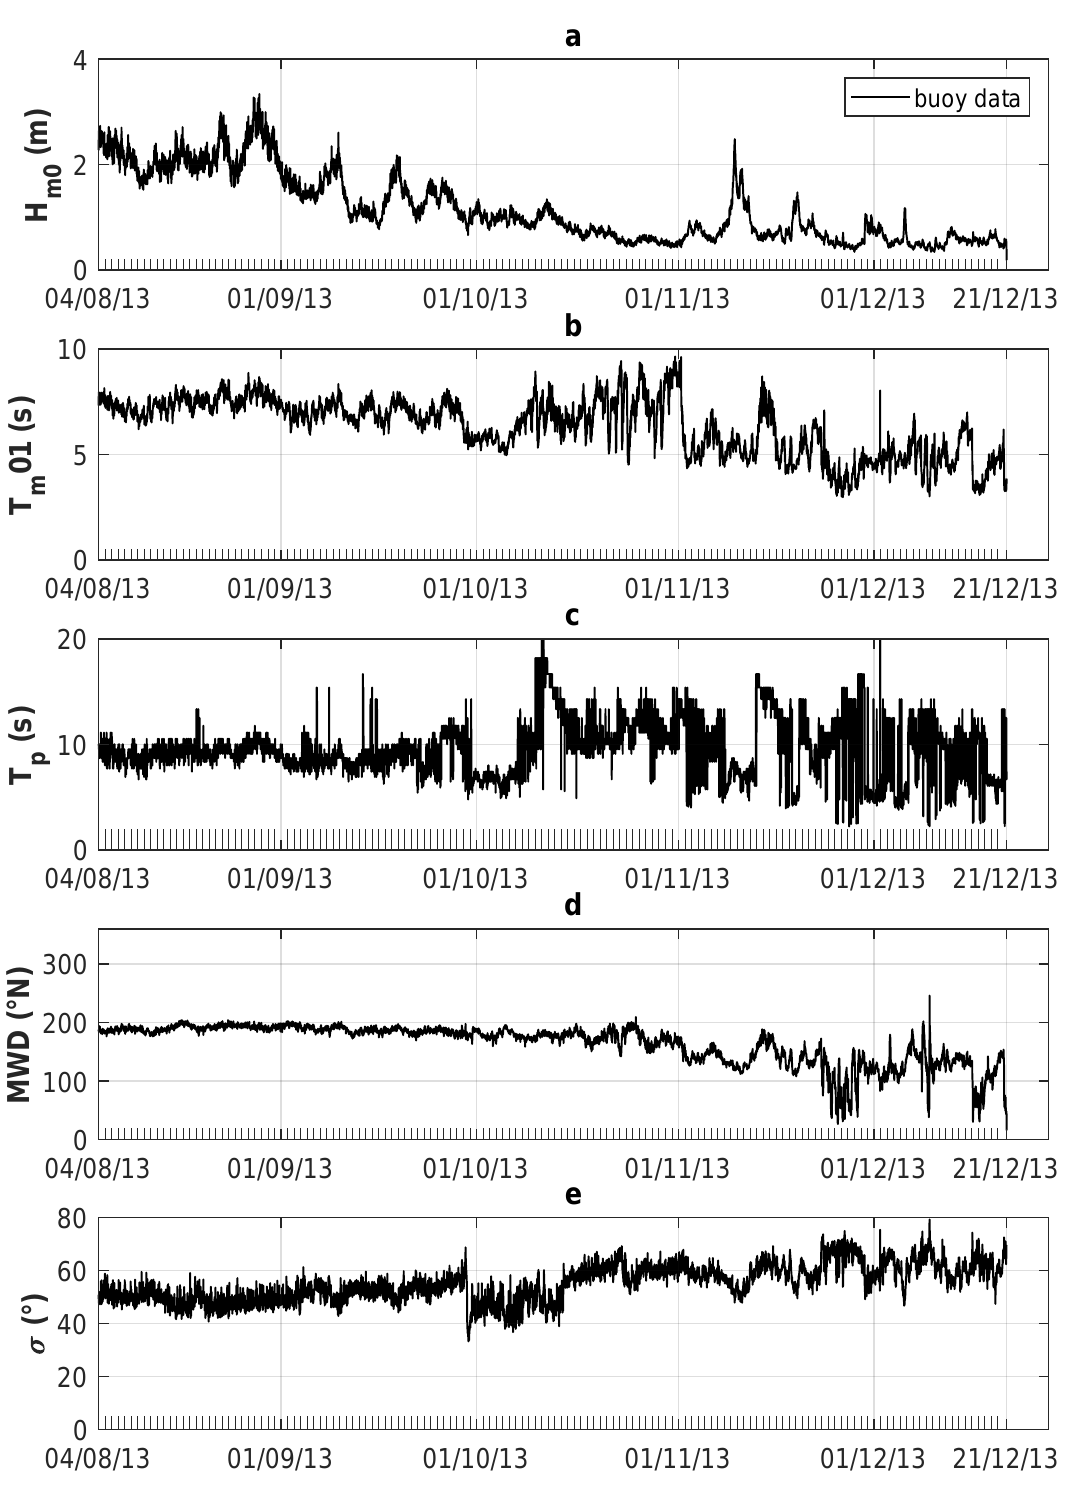
Figure 3. Time series plot of significant wave height H m 0 ( a ), mean wave period T m 01 ( b ), peak wave period T p ( c ), mean wave direction MWD ( d ) and directional spread σ ( e ) from August to December 2013. Wave parameters estimated using zero up-crossing analysis are listed in Table 1. The maximum value of H max in the monsoon period reaches about 6 m. It can be noted that the average valuse of H max and H 1/3 in the monsoon period are about 2.5 times larger than the values in the